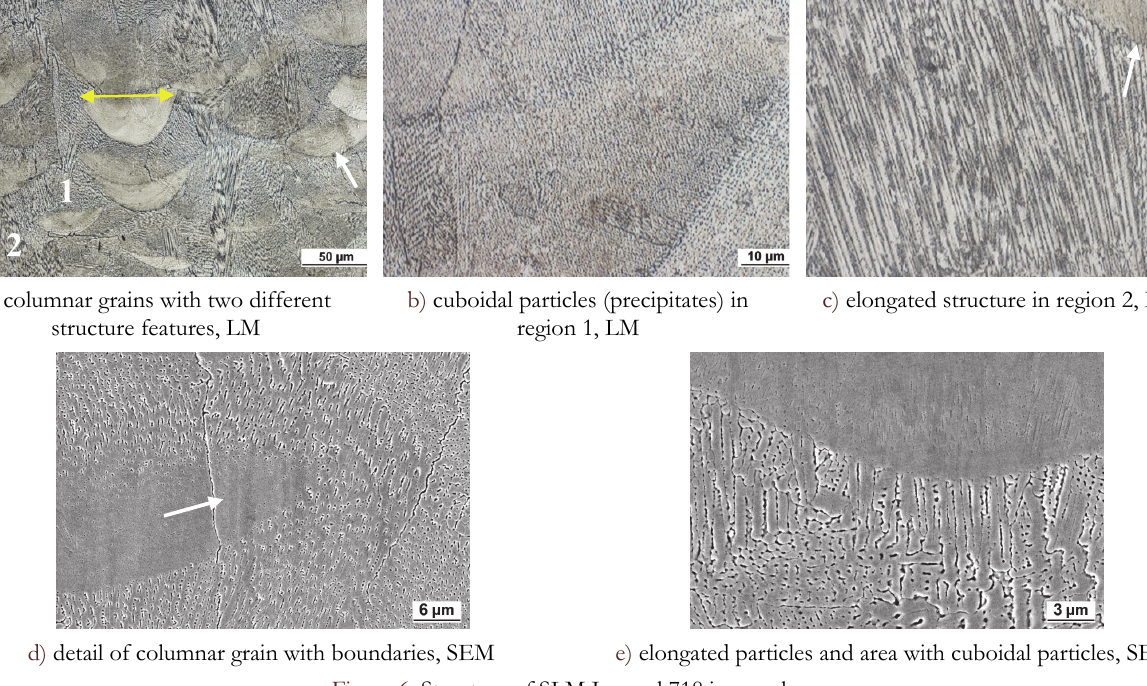
Figure 6: Structure of SLM Icnonel 718 in x-z